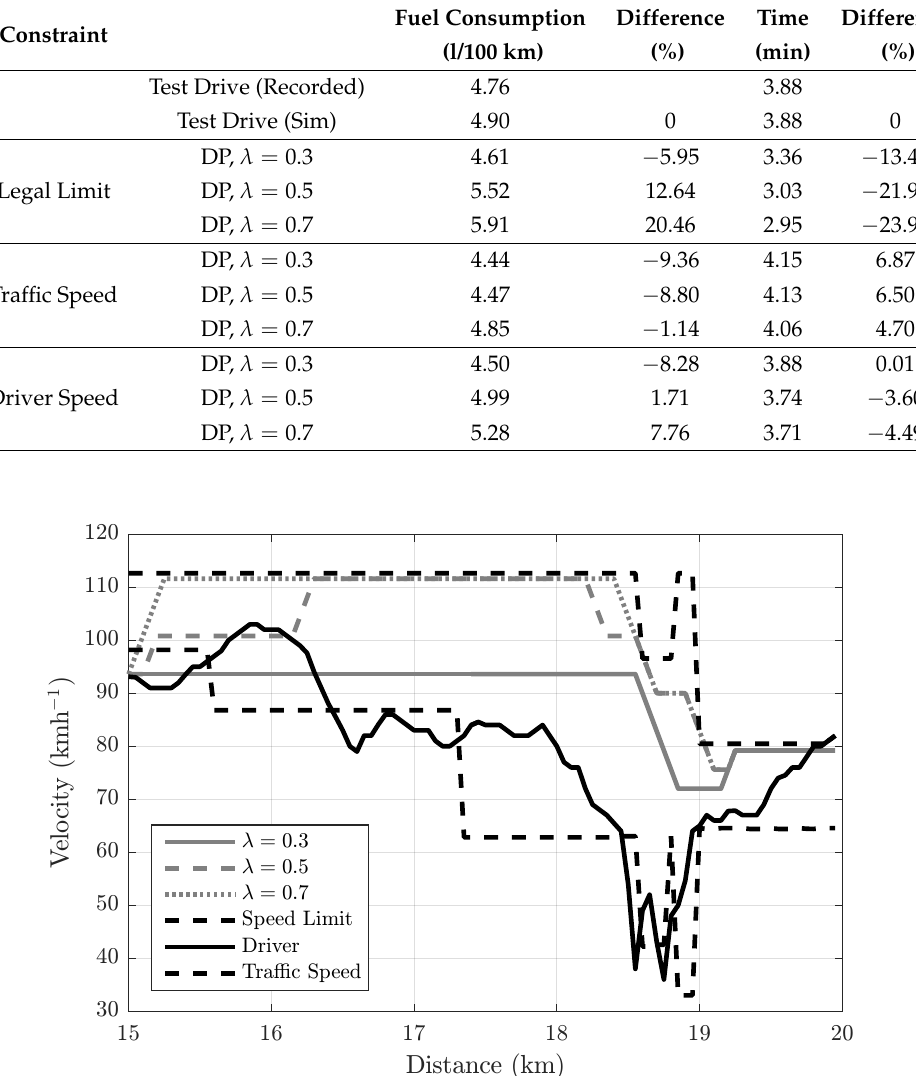
Table 2. Fuel consumption and time from a 5km section of the test drive. The recorded test drive velocity and gear profile are used to simulate fuel consumption and compared to results from the DP algorithm with an upper velocity constraint of (1) legal speed limit, (2) traffic speed +10% and (3) driver speed +10%.